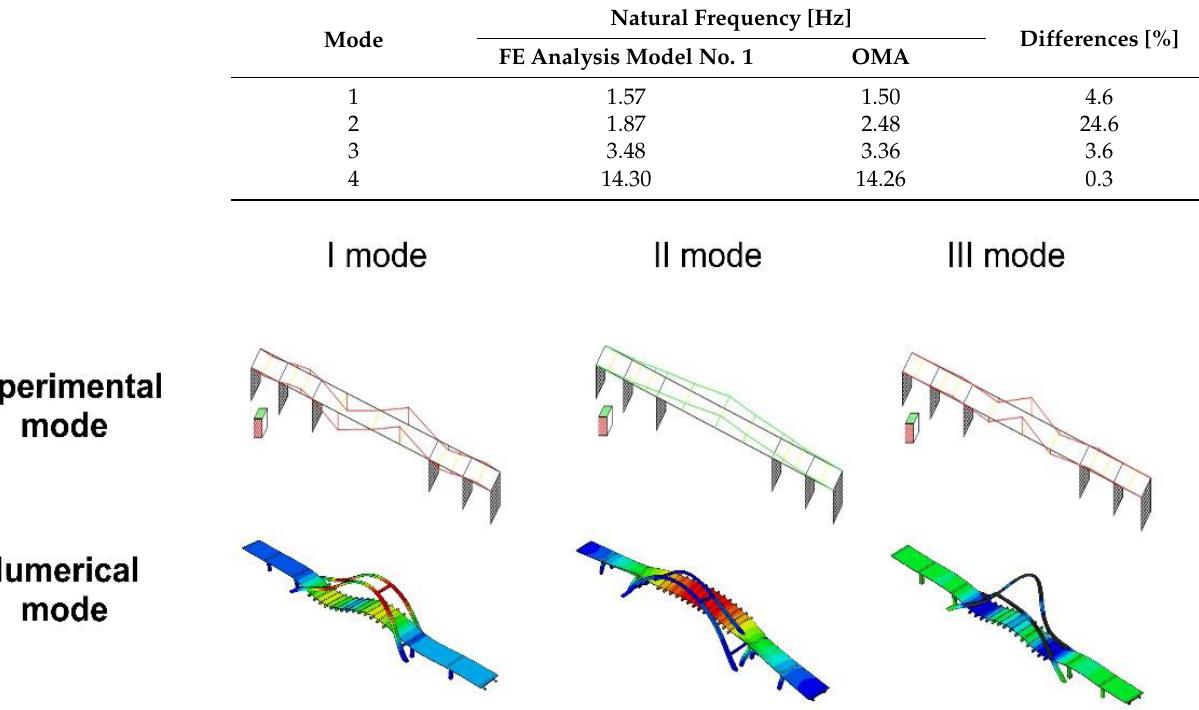
Figure 8. Comparison of the basic modes of vibration of the bridge obtained in the experimental and the numerical way.